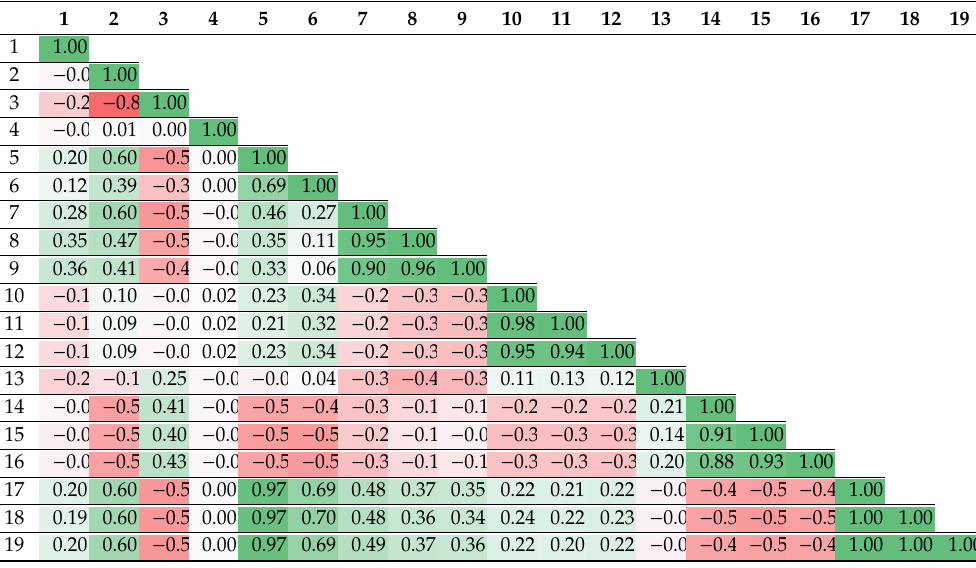
Table 6. Correlation matrix of PQ and weather parameters for 1 min aggregated